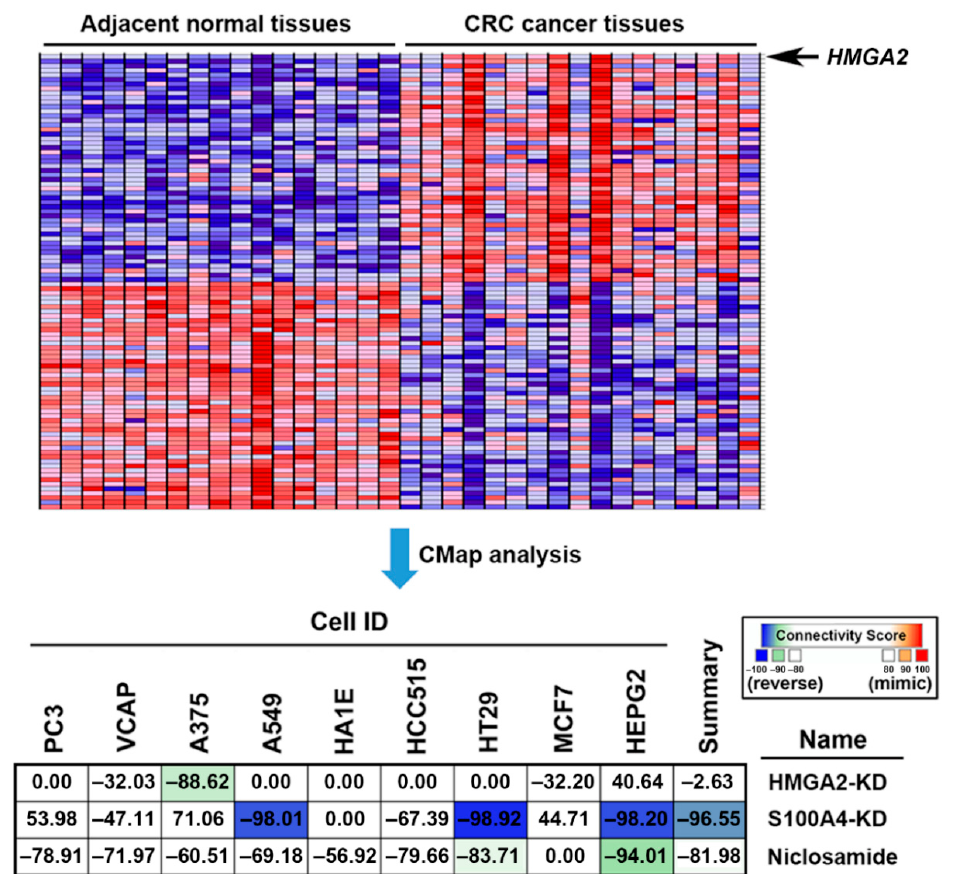
Figure 6. The clinical implication of S100 calcium-binding protein A4 (S100A4)-targeting niclosamide for colorectal cancer. The upper part: The most similar and dissimilar genes with HMGA2 were generated using GSEA and were visualized as a heat map. The lower part: Connections of HMGA2-driven gene signature in colorectal cancer patients with the HMGA2 / S100A4 knockdown and niclosamide were analyzed by querying the CLUE database (https: // clue.io / ). Connections were viewed as a heat map ranked by the summary connectivity score.